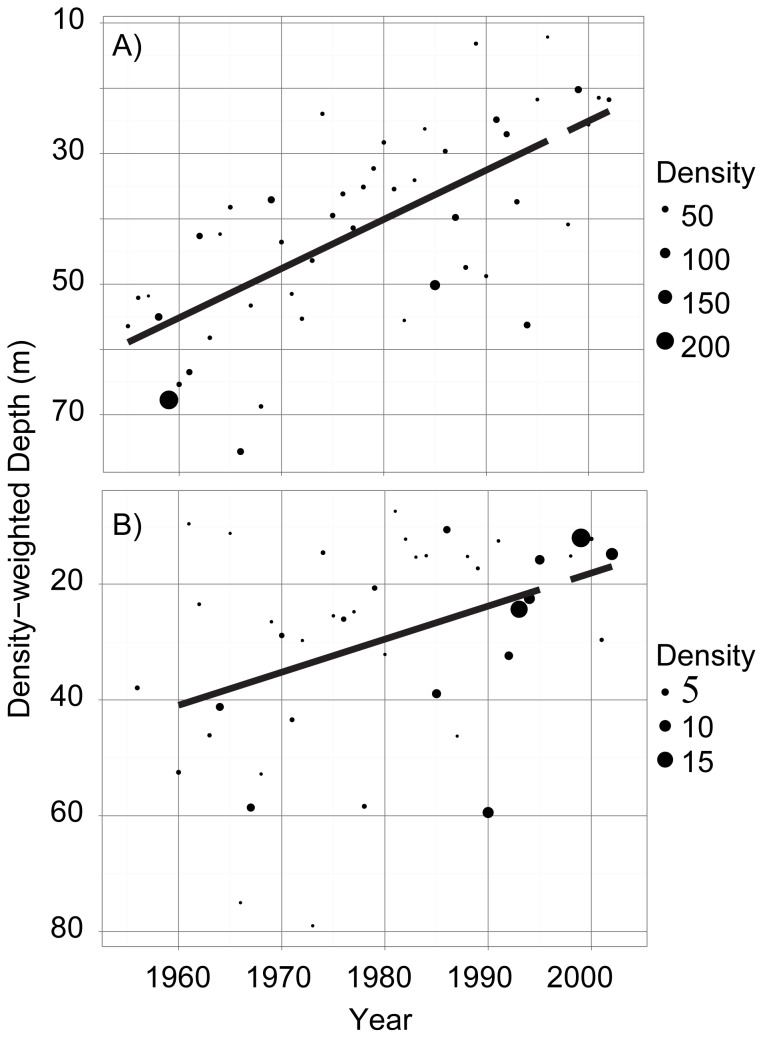
Abundance and density-weighted depth of rotifers (Panel A) and cladocerans (Panel B) in Lake Baikal.